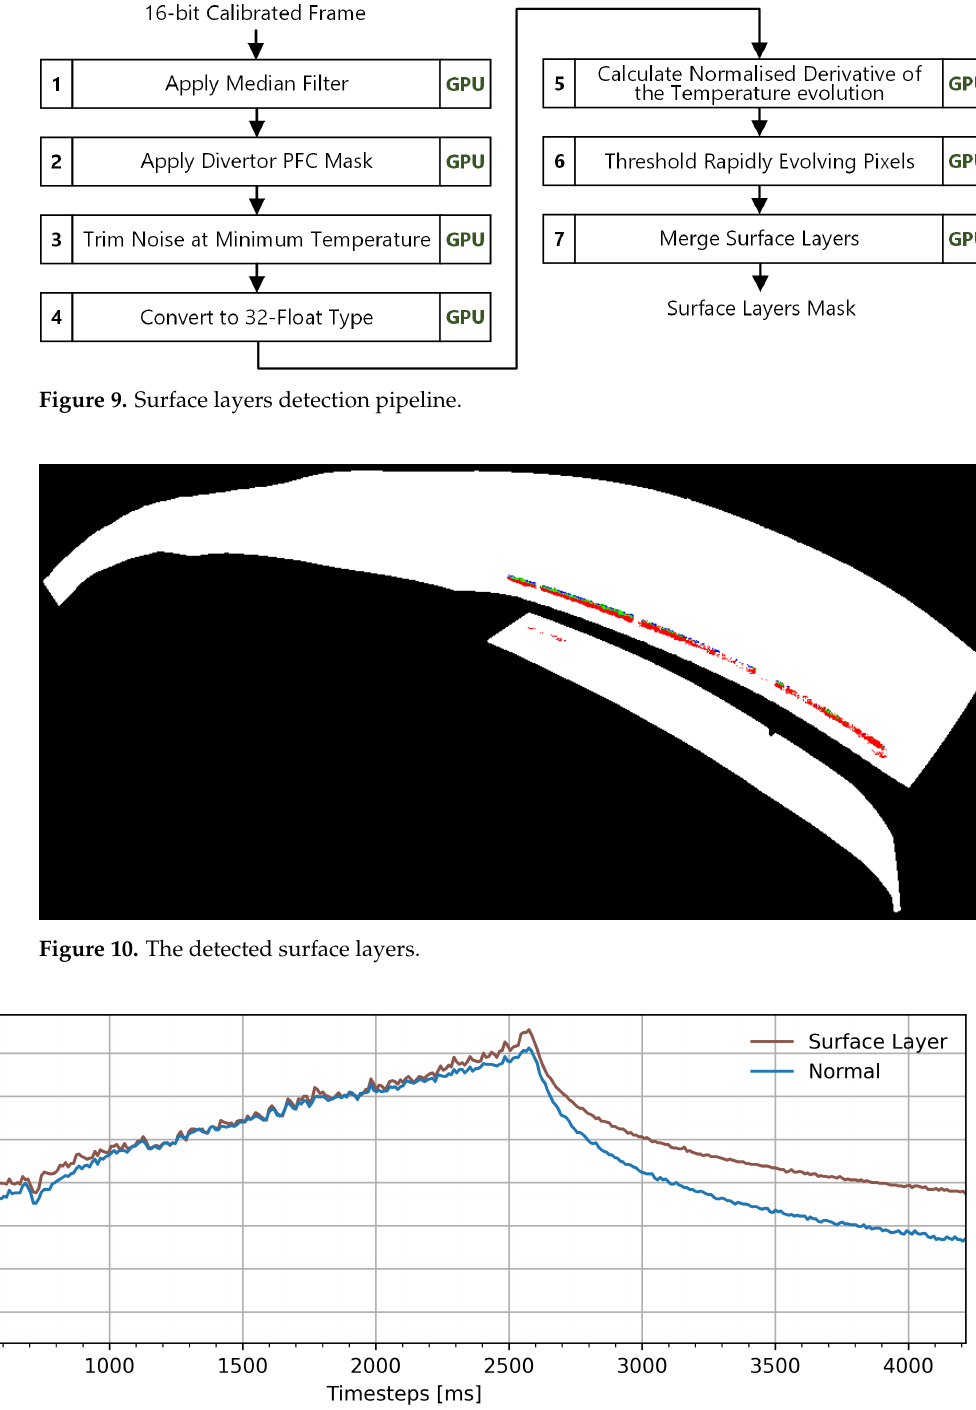
Figure 11. Surface temperature evolution of an area with detected surface layers and a normal